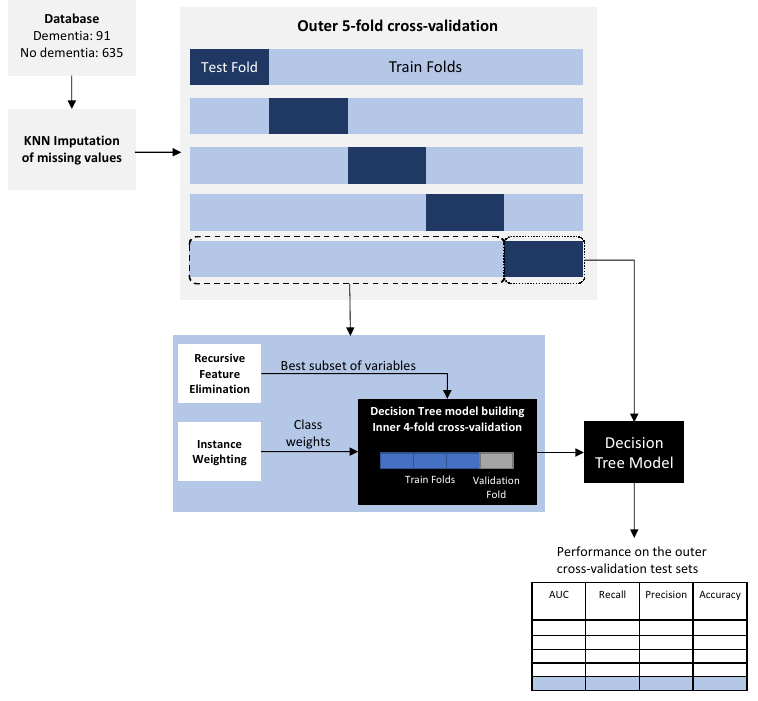
Figure 1. Overview of the proposed approach.